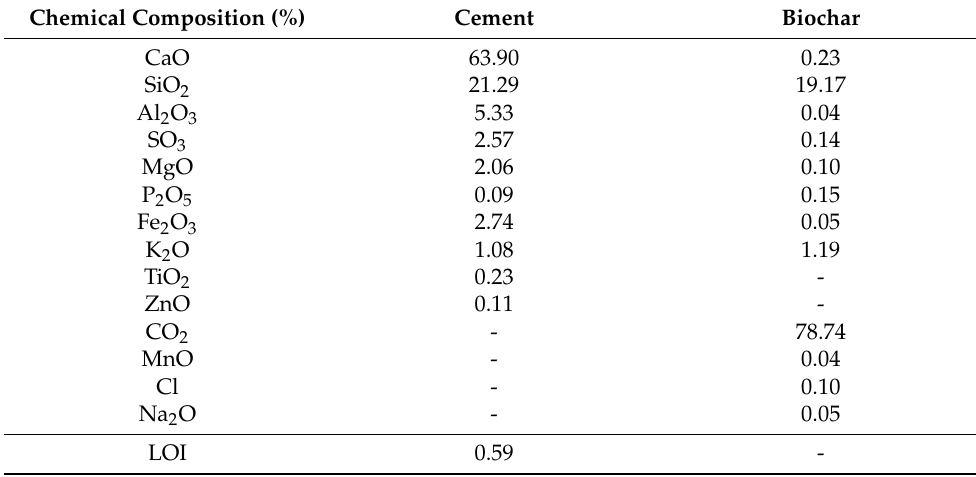
Table 1. Chemical compositions of biochar and cement.